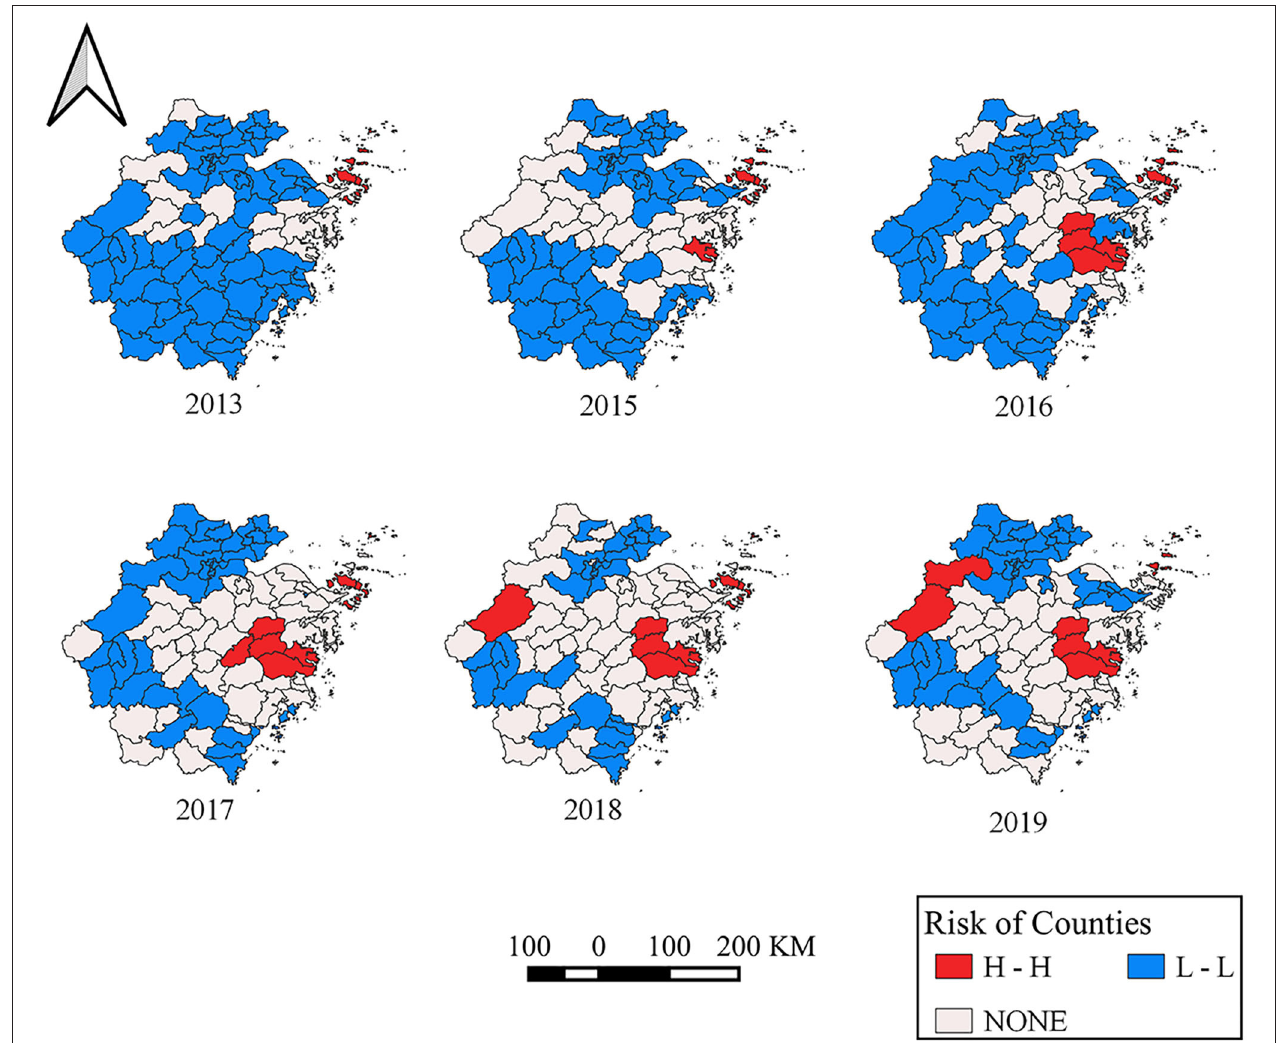
FIGURE 7 | Annual local Getis-Ord G i *Cluster Map in Zhejiang Province from 2011 to